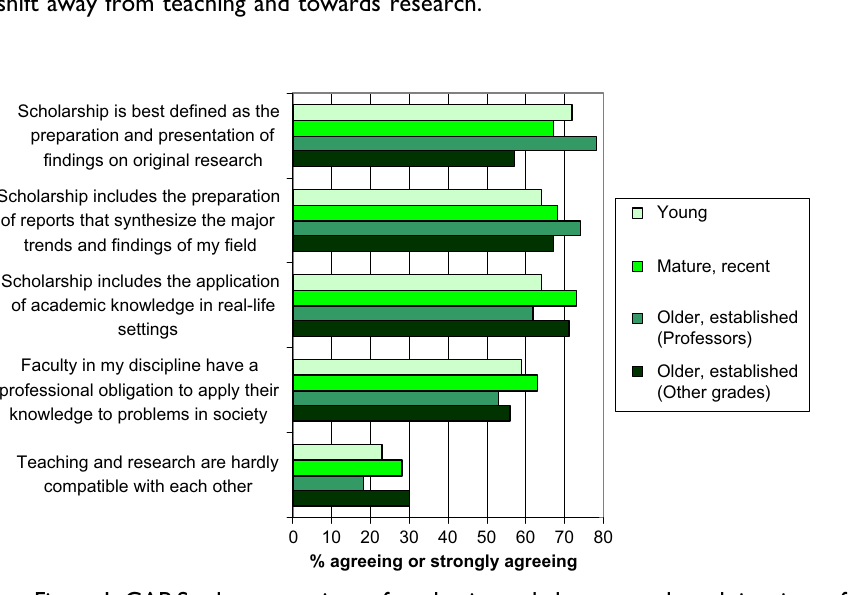
Figure 1. CAP Study: conceptions of academic work, by age, grade and time in profession